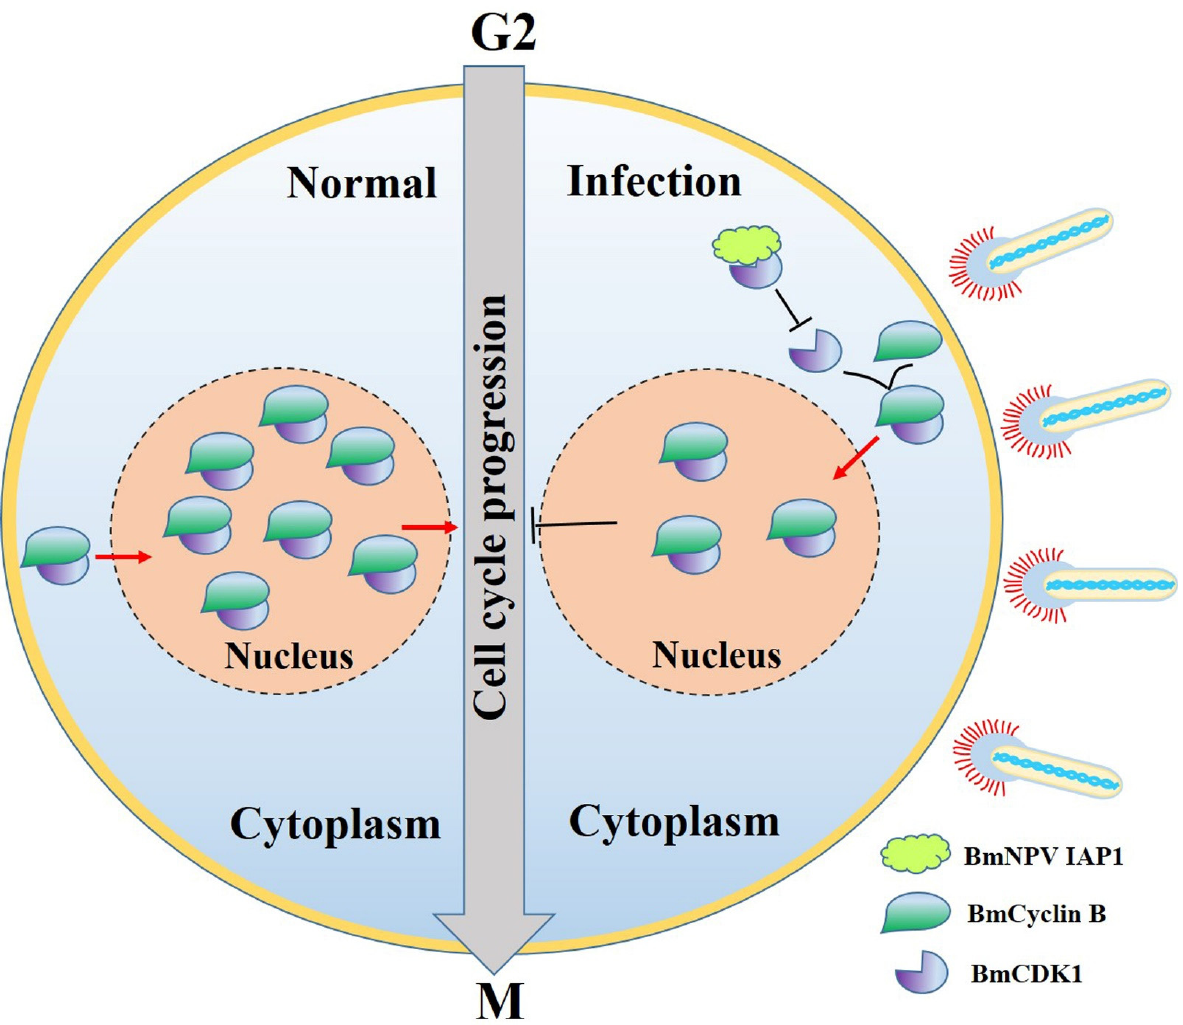
Figure 6. Schematic diagram of the molecular mechanism of BmNPV-mediated cell cycle arrest. Following BmNPV infection, BmNPV IAP1 interacts with BmCDK1 and inhibits the expressions of BmCDK1. These events result in reduced levels of BmCyclin B-BmCDK1 complexes and subsequent G2/M arrest.